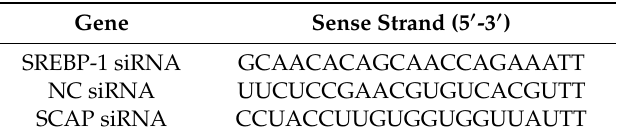
Table 2. Sequence of target gene